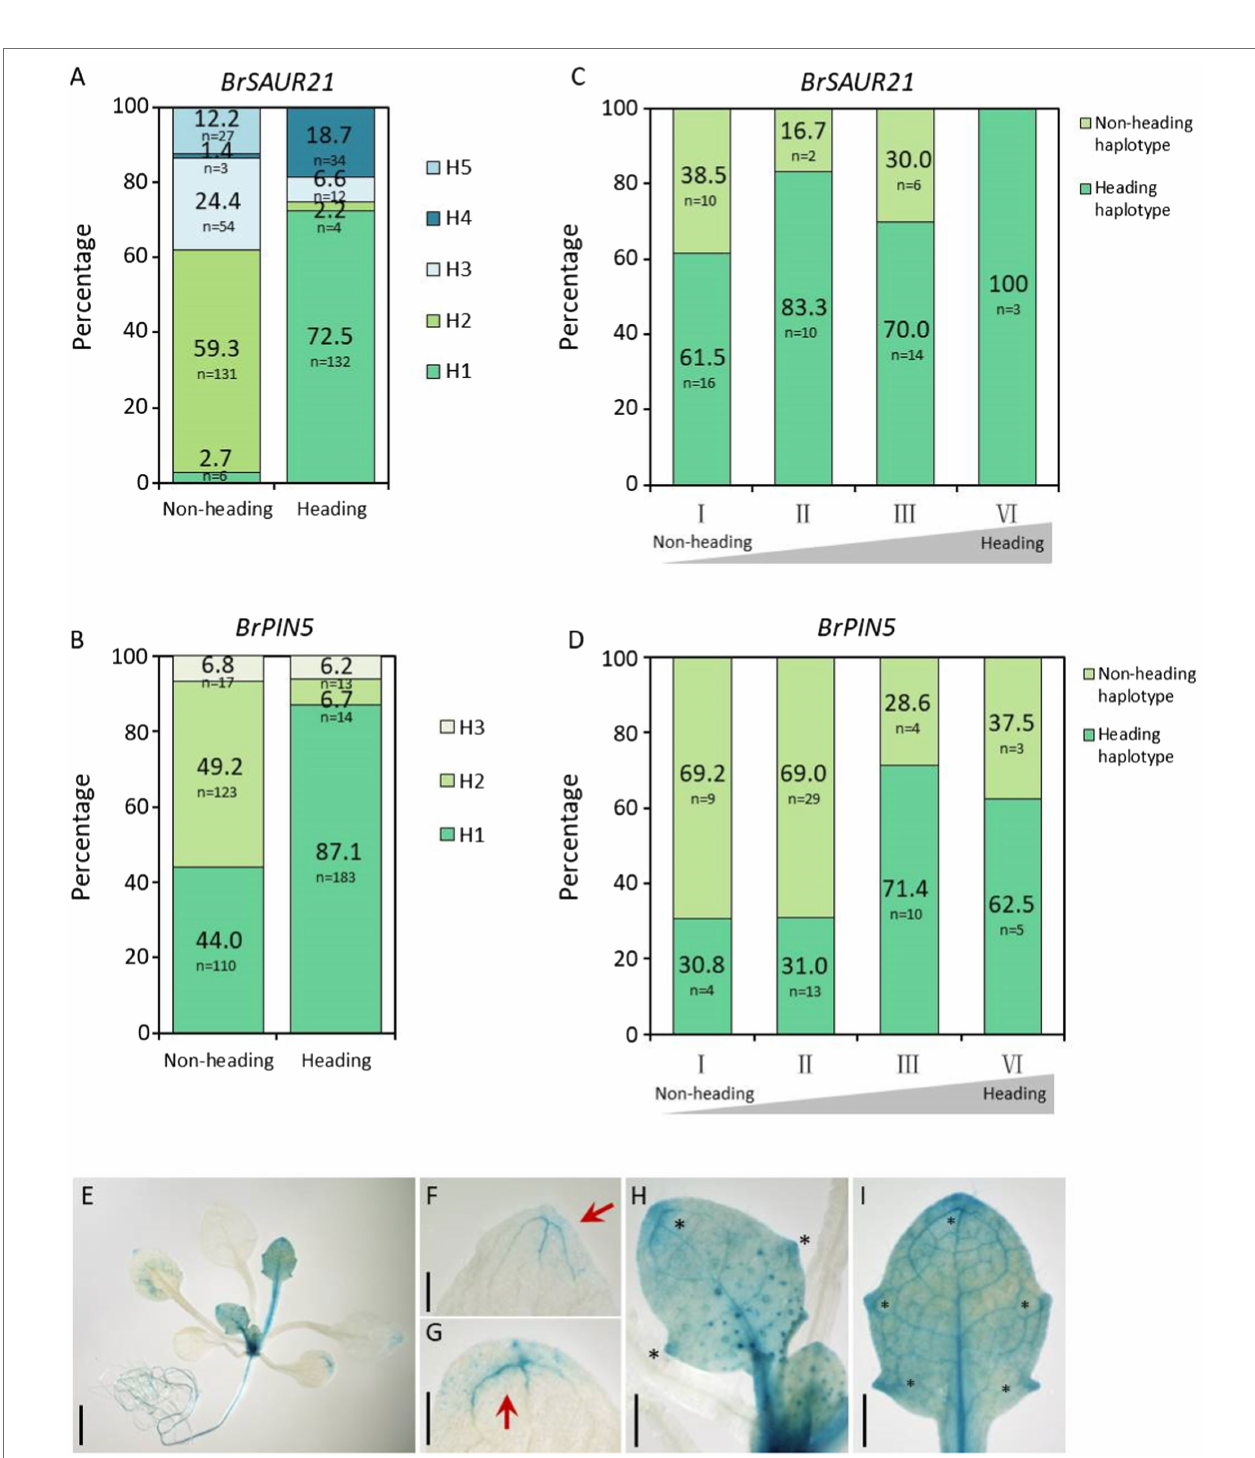
FIGURE 7 | Haplotype analysis of BrSAUR21 and BrPIN5 in natural lines and in two DH segregation populations. Haplotype analysis of BrSAUR21 (A) and BrPIN5 (B) based on the SNPs and Indels in the gene bodies using 460 natural lines (see SNPs/Indels of BrSAUR21 and BrPIN5 in Supplementary Figure S9 . The definitions of haplotypes H1-H5 for BrSAUR21 (A) and H1–H3 for BrPIN5 (B) were denoted in details in Supplementary Figure S9 . Haplotype analyses of BrSAUR21 (C) and BrPIN5 (D) using the two DH populations (see details in “Materials and Methods”). For both genes, the heading haplotype was defined as the haplotype that is from Chinese cabbage; I to IV indicate the heading levels from non-heading to heading. (E–I) The PIN5::GUS expression pattern in leaf veins of Arabidopsis. Red arrows and black asterisks show the regions with strong signals in cotyledon (G) and true leaves (F , H,I) . Scale bars: 2 mm (E) 500 μ m (F–I)